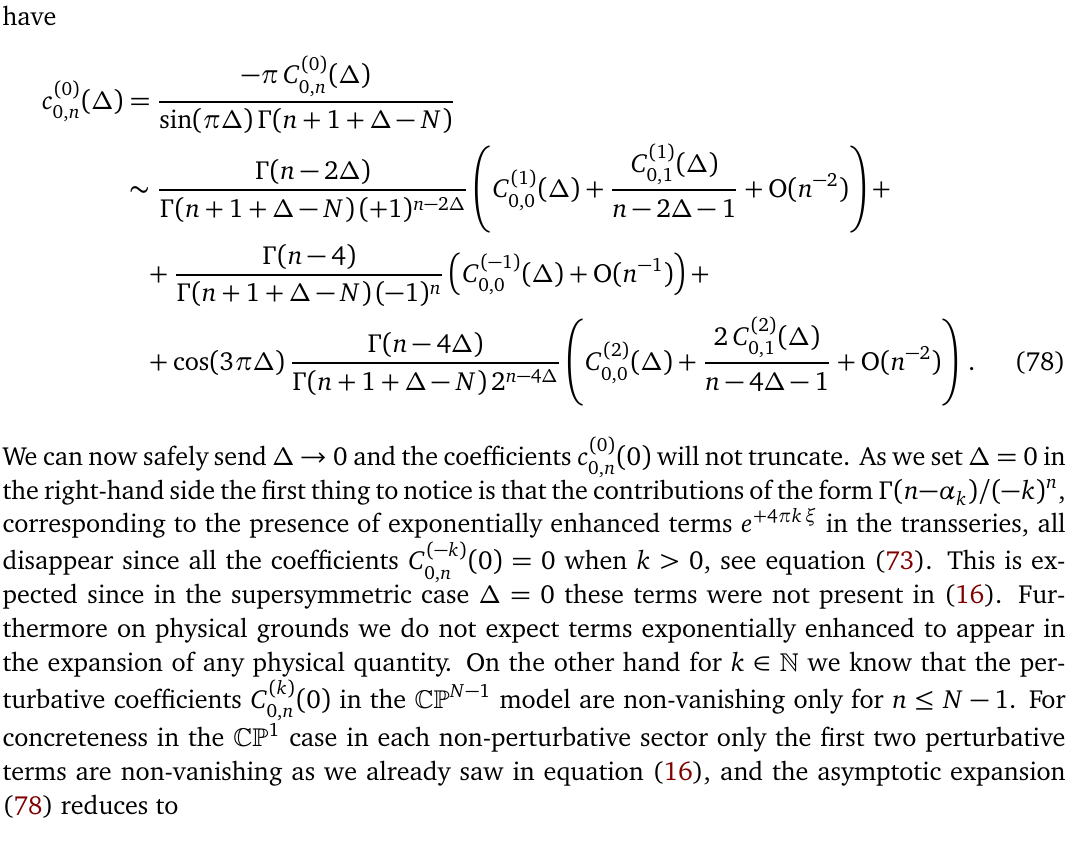
between the perturbative coefficients C n ( 0 ) , as ( 1 / 3 ) . The blue line is given by the equation 0, n